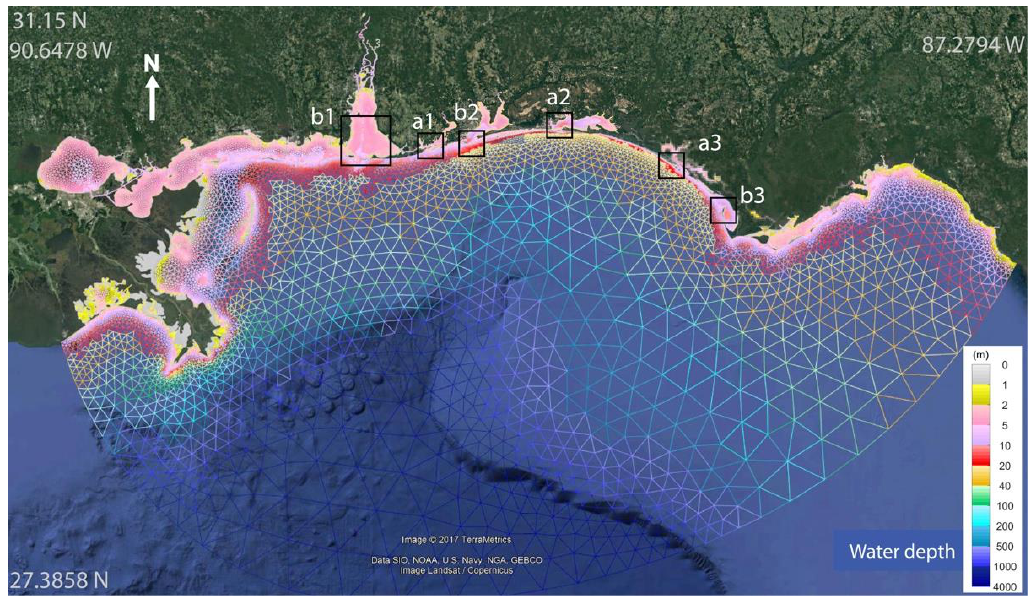
Figure 3. The newly developed tidal model grid for north-east Gulf of Mexico. Colors indicate water depth in meter. See Figure 4 for the close-ups in the boxes. Background image is from Google Earth.